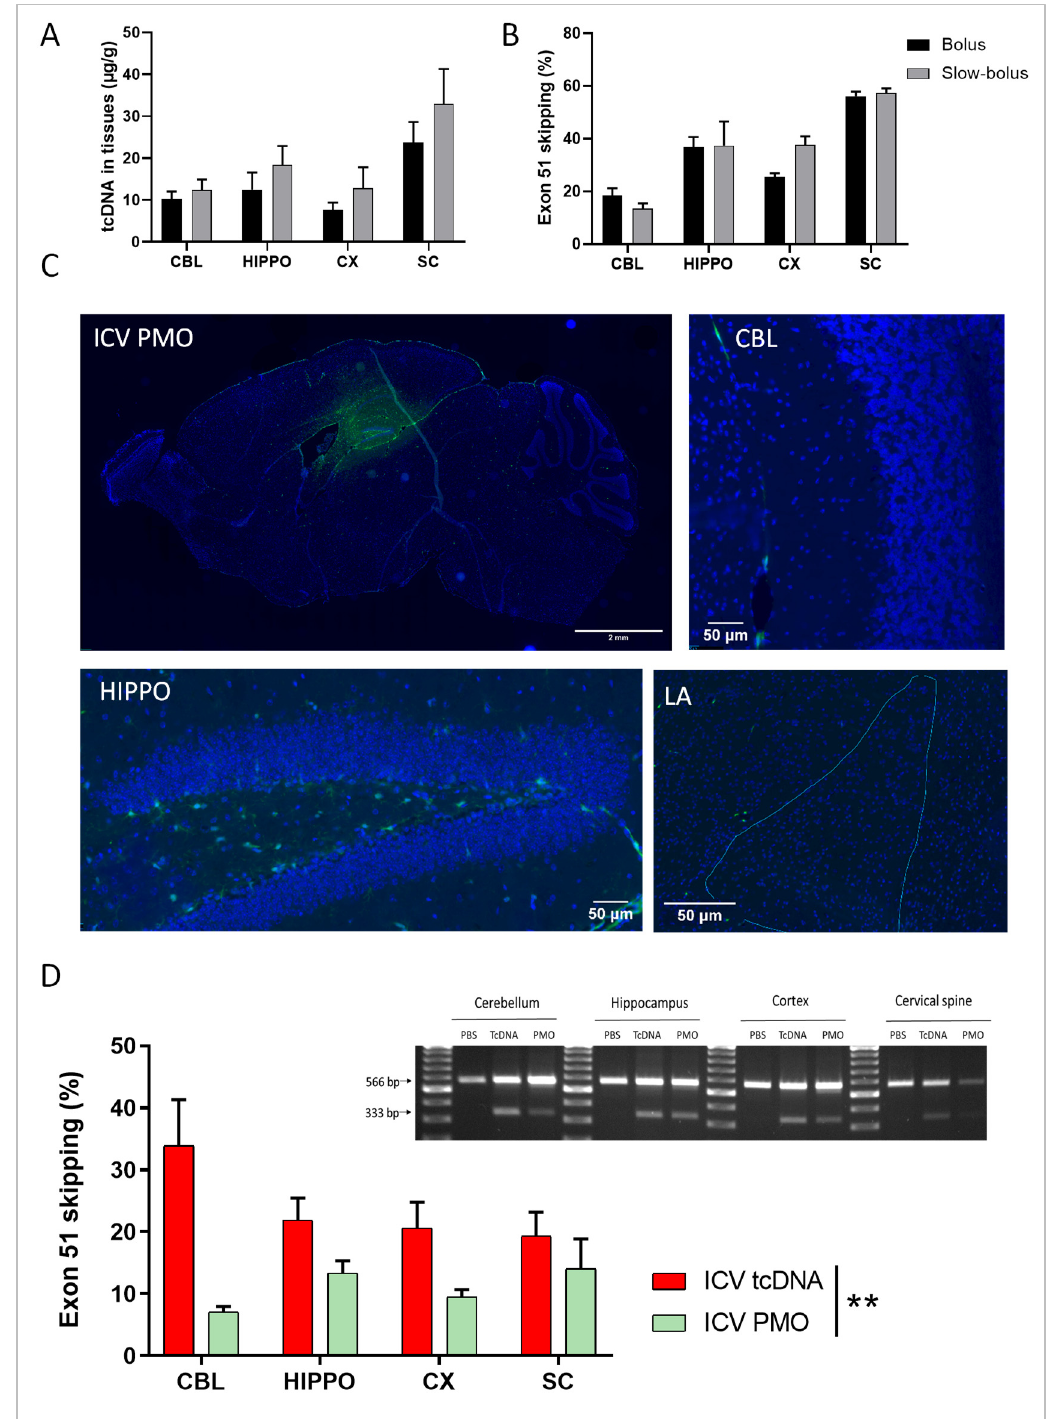
Figure 1. Quanti fi cation of tcDNA and PMO in speci fi c brain regions and exon skipping after single ICV delivery. ( A ) Quanti fi cation by fl uorescent hybridization assay of tcDNA-Ex51 content in various CNS tissues 4 weeks after the ICV administration using a bolus or a slow-bolus rate. Results are expressed as means ± SEMs; n = 4 hDMD-tcDNA-Ex51. ( B ) Quanti fi cation of exon 51-skipping levels via RT-qPCR in di ff erent brain tissues 4 weeks after the ICV administration using a bolus or a slow-bolus rate. Results are expressed as means ± SEMs; n = 4 hDMD-tcDNA-Ex51. ( C ) Carboxy fl uorescein-conjugated PMO detected 48 h post-ICV slow-bolus rate delivery. Representative images show a sagi tt al section (scale bar 2mm), cerebellum lobules IV-V (CBL), hippocampus dentate gyrus (HIPPO), and the lateral amygdala (LA), n = 3, (scale bars 50 µm). ( D ) Left panel: quanti fi cation of